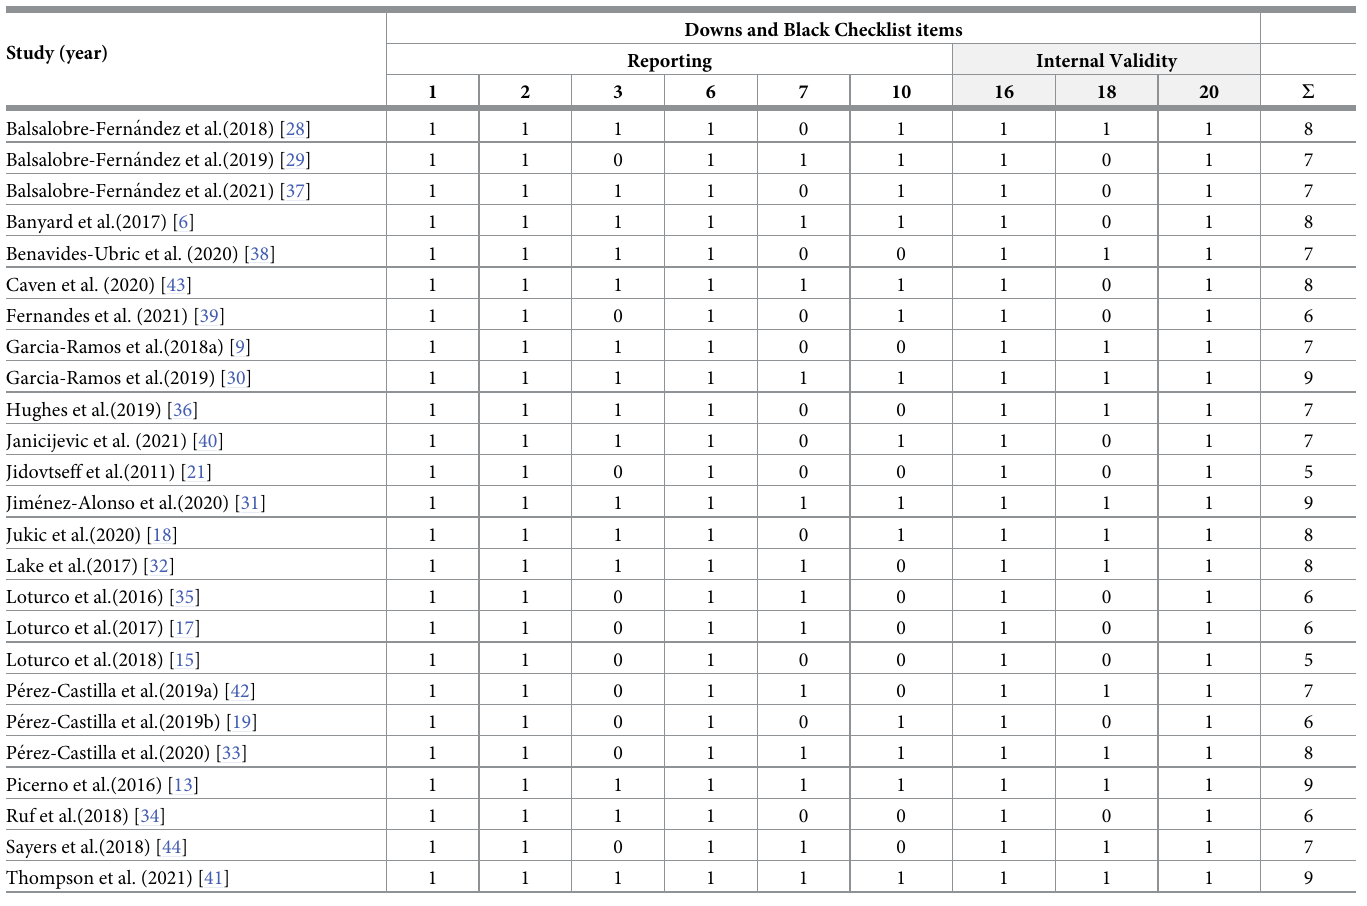
Table 2. Assessment of reporting quality of included